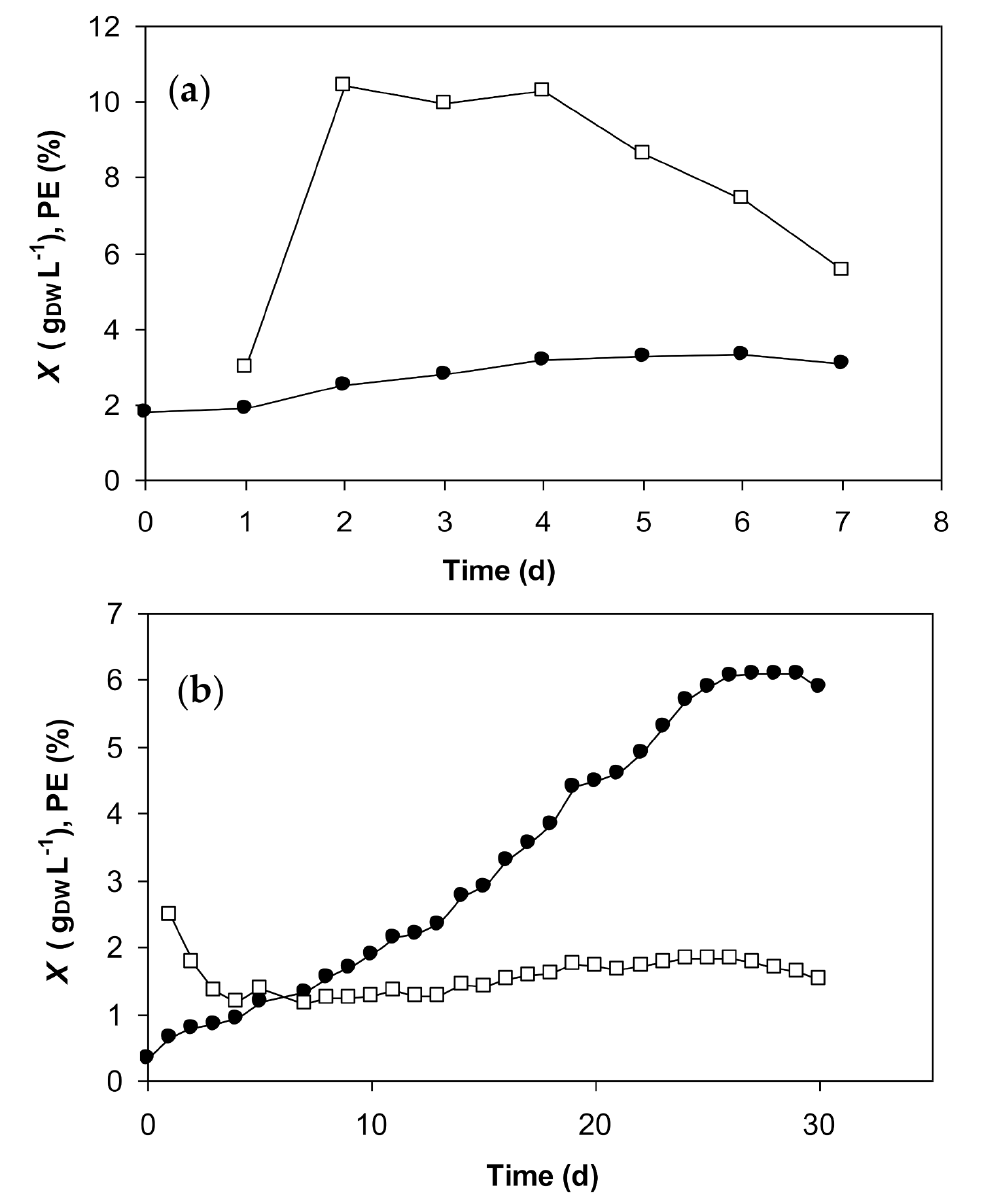
Figure 2. Time behaviors of biomass concentration ( X , • ) and photosynthetic efficiency (PE, (cid:3) ) along fed-batch pulse-feeding cultivation of Arthrospira platensis in a helical photobioreactor at a PPFD